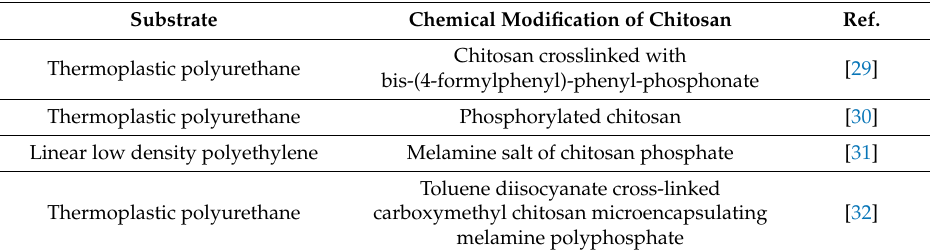
Table 1. Main chemical modifications of chitosan for flame retardant